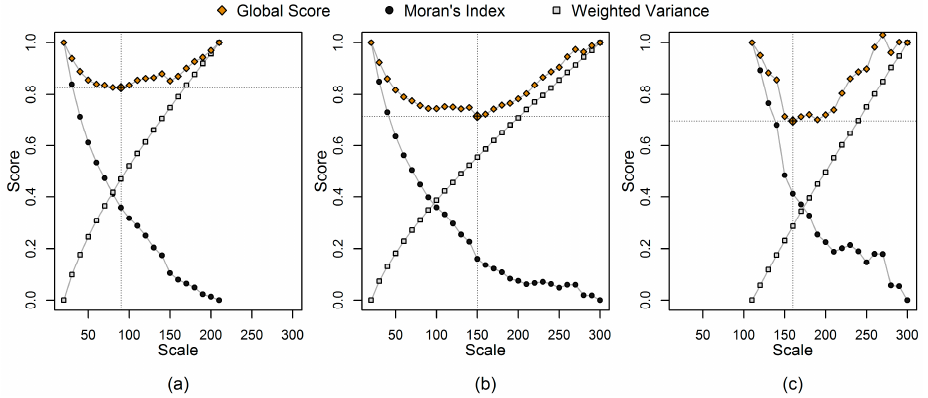
Figure 2. Results for Global Score ( GS ), Moran’s Index ( I ) and Weighted Variance ( v ) using the normalized measures calculated for the set of test segmentations, where ( a ) is restricted to a subset of Scale between 20 and 210, ( b ) is the full set of Scale ranging from 20 to 300 and ( c ) is the subset of Scale ranging from 110 to 300. While the optimum of the full set shown in ( b ) is contained in both ( a , c ), each set reports a different segmentation as optimal.